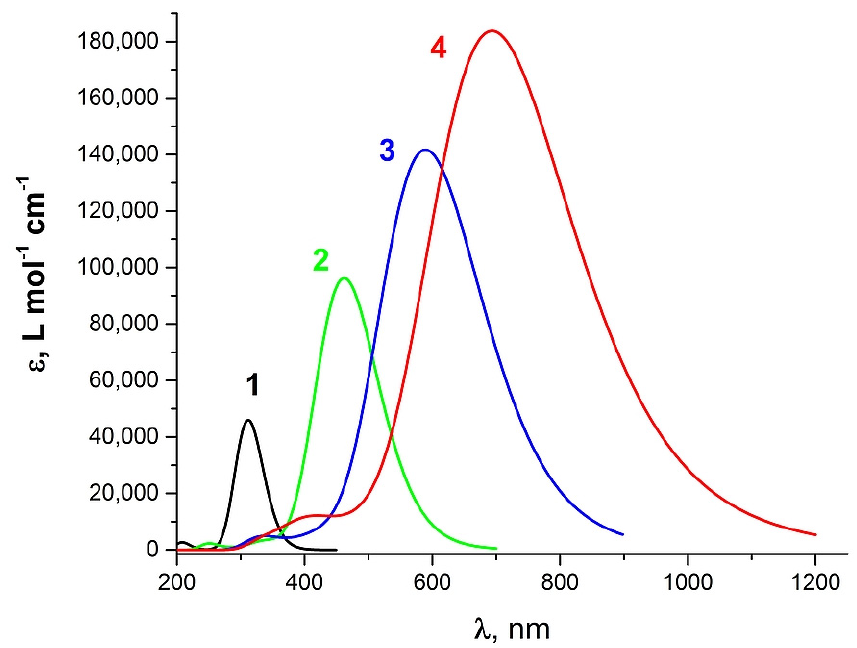
Figure 3. Calculated (B3LYP/aug-cc-pVDZ//B3LYP/aug-cc-pVDZ model chemistry) absorption spectra of molecules 1 – 4 (Chart 1) in dichloromethane; TD-SCF was solved for 10 states.